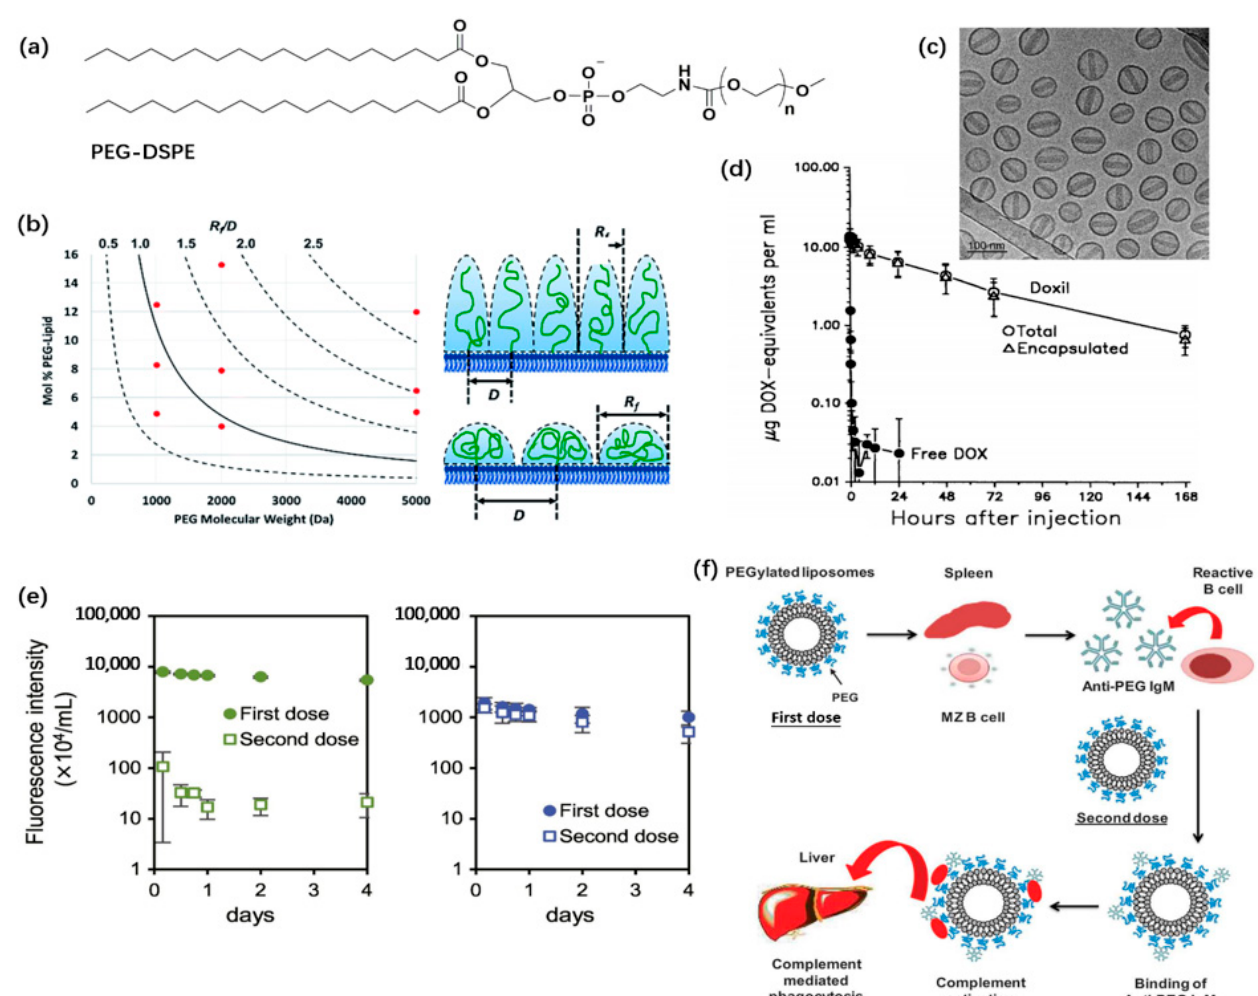
Figure 4. PEGylated liposomal formulation. ( a ) Chemical structure of PEG-DSPE conjugate, where n represents the number of repeating units; ( b ) Determination of the configuration of surface-grafted polymer; ( c ) TEM image of PEGylated doxorubicin; ( d ) Pharmacokinetics of PEGylated liposomal doxorubicin (open symbols) and free drug (solid symbols); ( e ) Blood concentration after the first and second doses (solid and open symbols, respectively) for PEGylated liposome induces ABC while poly(sarcosine)-modified liposomes do not cause ABC; ( f ) Mechanism of ABC induced by repeated administration of PEGylated liposomes. The panel ( b ) is adapted with permission from Ref. [54], published by Royal Society of Chemistry, 2018. The panel ( c ) is adapted with permission from Ref. [5]; Copyright © 2012 Elsevier B.V. All rights reserved. The panel ( d ) is adapted from Ref. [62]; Copyright © 1994, American Association for Cancer Research. The panel ( e ) is adapted with permission from Ref. [63]; Copyright © 2020 Elsevier B.V. All rights reserved. The panel ( f ) is adapted from Ref. [64], an Open Access article distributed under the terms of the Creative Commons